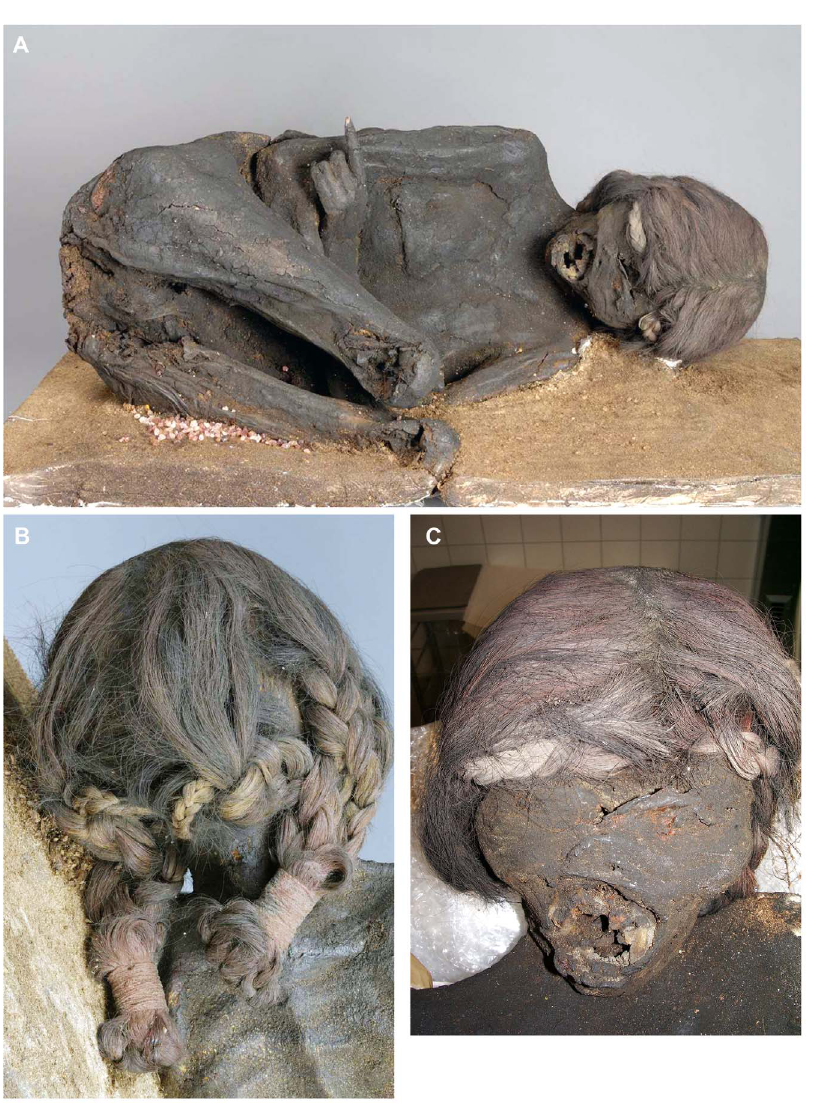
Figure 1. Macroscopic aspect of the mummy. ( A ) Frontal view of the mummy which reveals typical squatting position (although the legs are broken off below both knees). ( B ) External appearance of the hair plaits which are fixed at their ends by tiny ropes of foreign material. ( C ) Detailed view of the mummy’s face. Note the transverse defect above the left eye. Both eyes are closed and covered by skin. The mouth is ovally opened, the frontal teeth are missing.